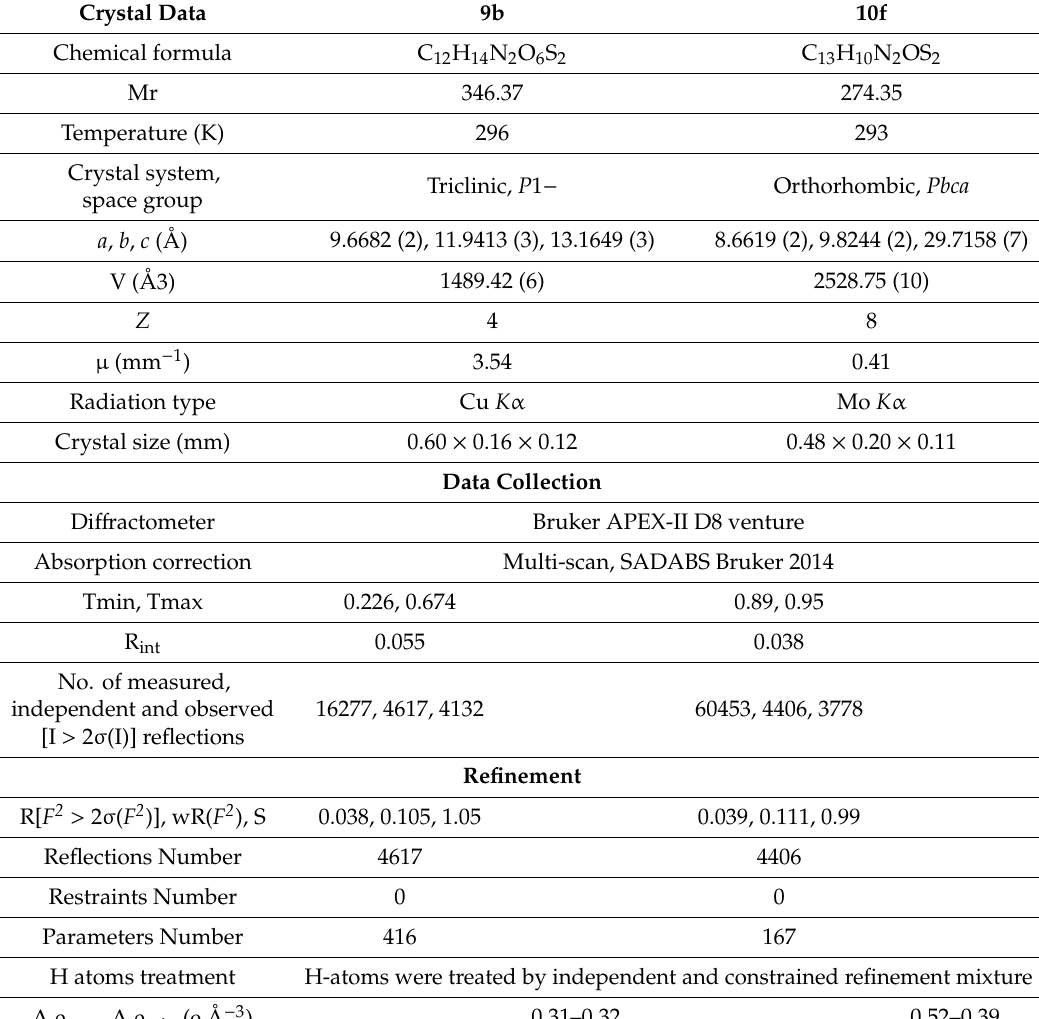
Table 8. Experimental details for imidazole sulfate-salt 9b and benzimidazole derivative